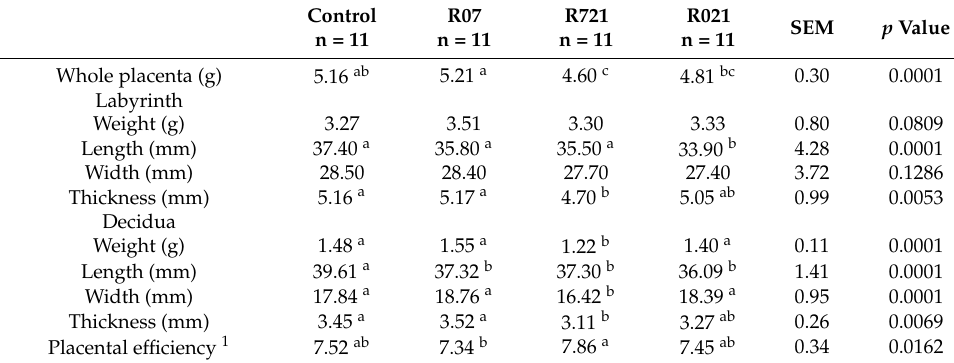
Table 2. Weight and dimensions of placentas from pregnant rabbits on day 28, fed ad libitum (Control), restricted to 60% one week from day 0 to 7 (R07), two weeks from day 7 to 21 (R721)